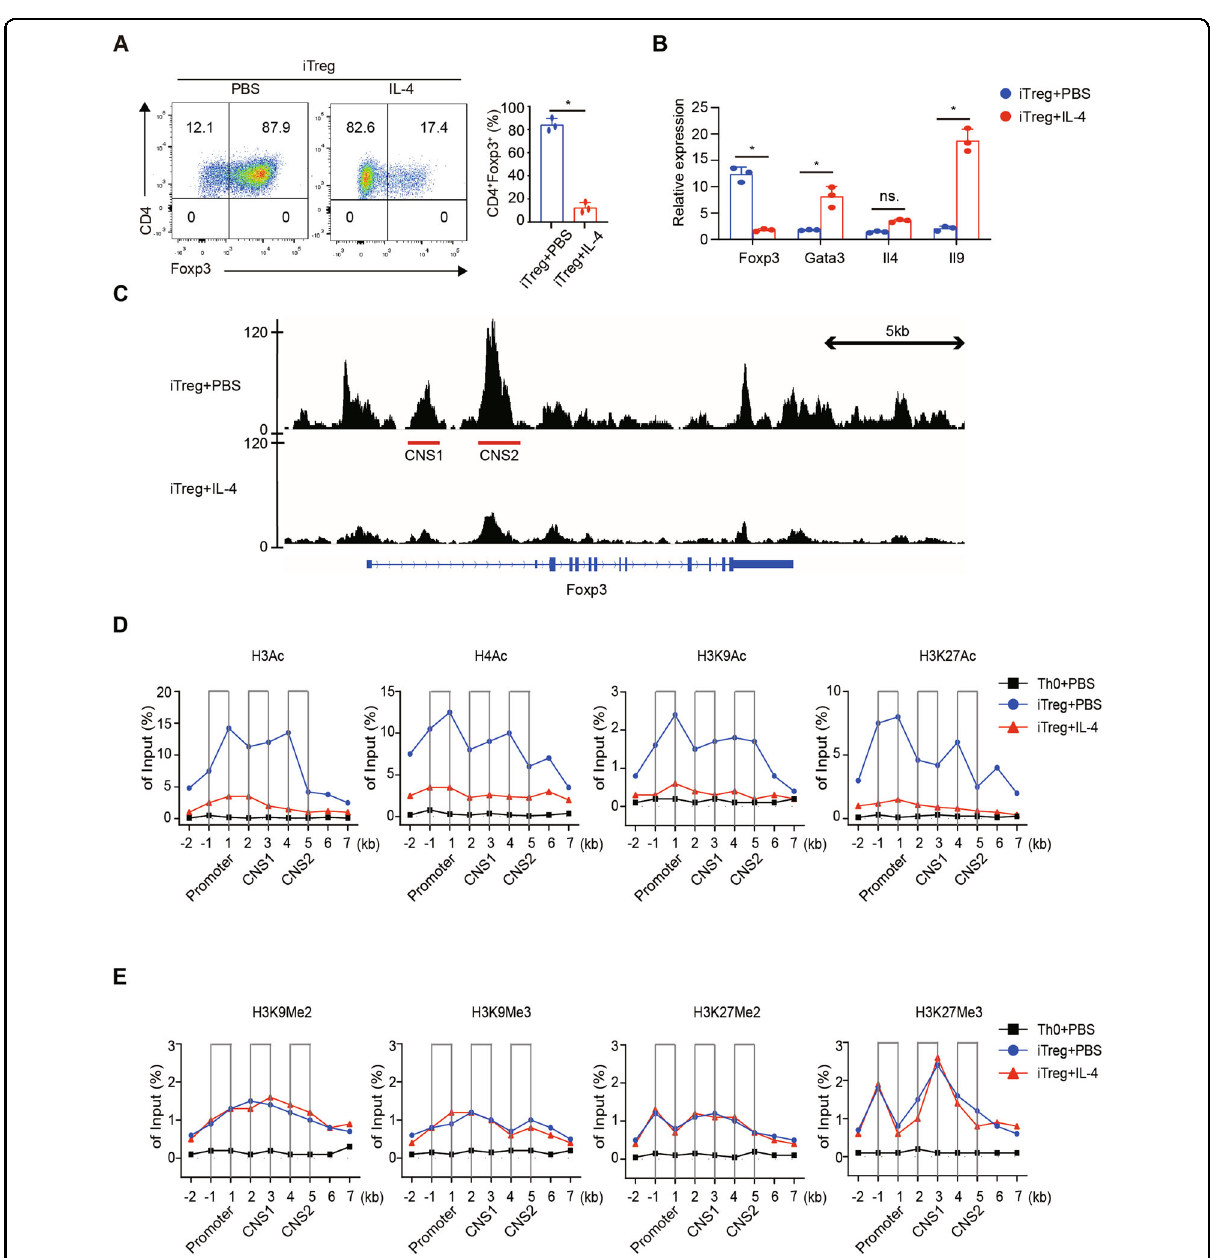
Fig. 1 IL-4 inhibits Foxp3 transcription and histone acetylation of Foxp3 locus. Naive CD4 + T cells from WT mice were cultured under Treg- polarizing conditions with or without IL-4. A Cells were harvested 3 days later and analyzed by FCM. The percentages of Foxp3 + cells are displayed in the quadrants. B On day 2, cells were harvested and analyzed by quantitative RT-PCR. The graphs display the relative mRNA expression of Foxp3, Gata3, Il9, and Il4. C On day 2, cells were prepared for ATAC-seq. Integrative Genomics Viewer (IGV) screenshots of representative ATAC-seq tracks from each group at the Foxp3 locus are shown. Red bands represent classic regulatory regions. The scales of the two tracks were adjusted to display comparable intensities, and the data are representative of two biologically independent pooled samples. D , E ChIP-qPCR analyses for H3Ac, H4Ac, H3K27Ac, H3K9Ac, H3K9Me2, H3K9Me3, H3K27Me2, and H3K27Me3 alterations at the Foxp3 locus were performed. Data are the mean ± SD and representative of three independent experiments. * p <